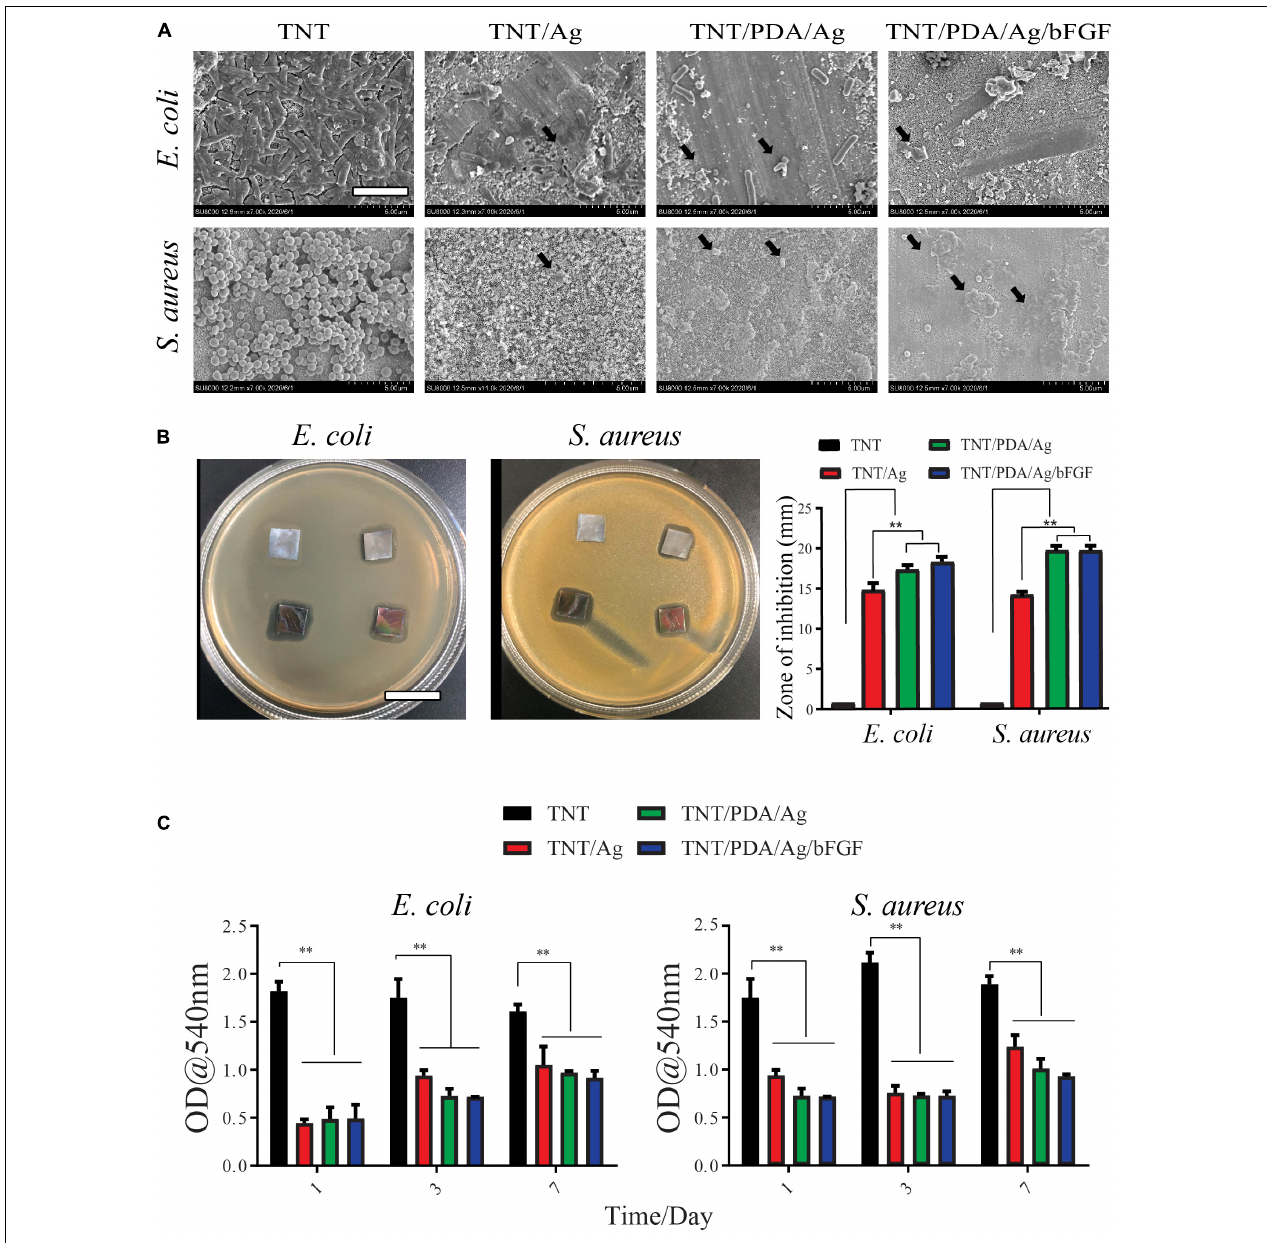
FIGURE 7 | Antibacterial properties of modified Ti samples. (A) Escherichia coli and Staphylococcus aureus were cultured on modified Ti surfaces for 12 h and imaged by SEM. Bacteria with damaged membrane and deformed shape were observed on TNT/Ag, TNT/PDA/Ag, and TNT/PDA/Ag/bFGF (black arrows). Scale bar represents 2 µ m. (B) Inhibition zone of Ti samples. The bacterial suspension was inoculated, and modified Ti samples were placed on agar plates for 24-h incubation. Bacterial free zone was measured and compared. Both TNT/PDA/Ag and TNT/PDA/Ag/bFGF showed significantly larger inhibition zones. Scale bar represents 2 cm. (C) Quantitative analysis of antibacterial ability against E. coli and S. aureus of Ti samples after being pre-released in sterile phosphate-buffered saline (PBS) for 1, 3, and 7 days. These pre-released Ti samples were placed with bacteria for 24 h. Data are presented as mean ± standard deviation; ** p <